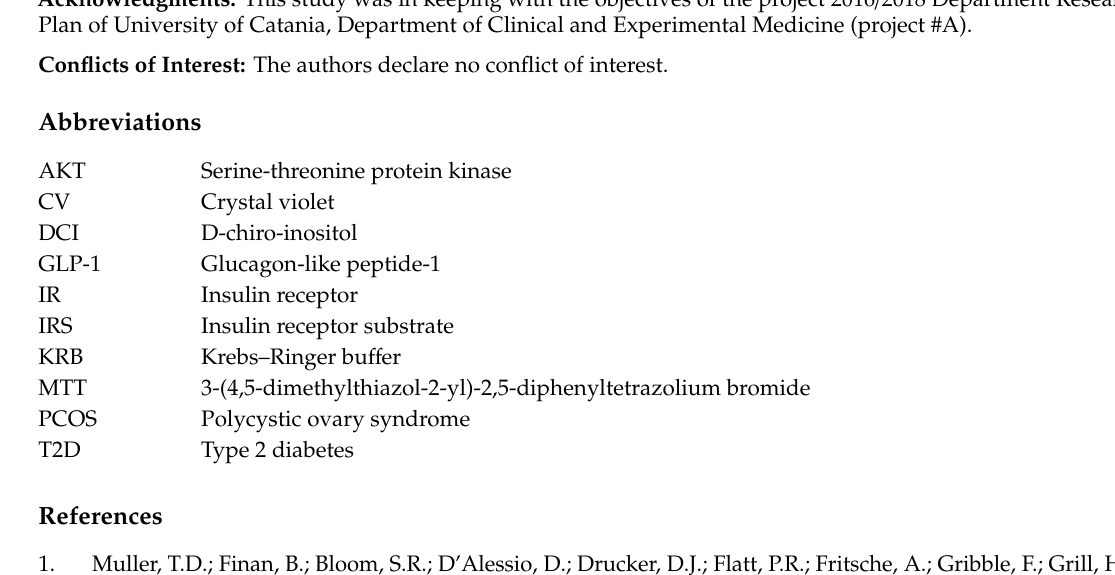
Figure S1: E ff ect of palmitate and DCI exposure on cell viability in α -TC1-6 cells. Figure S2: E ff ect of DCI exposure on cell viability in INS-1